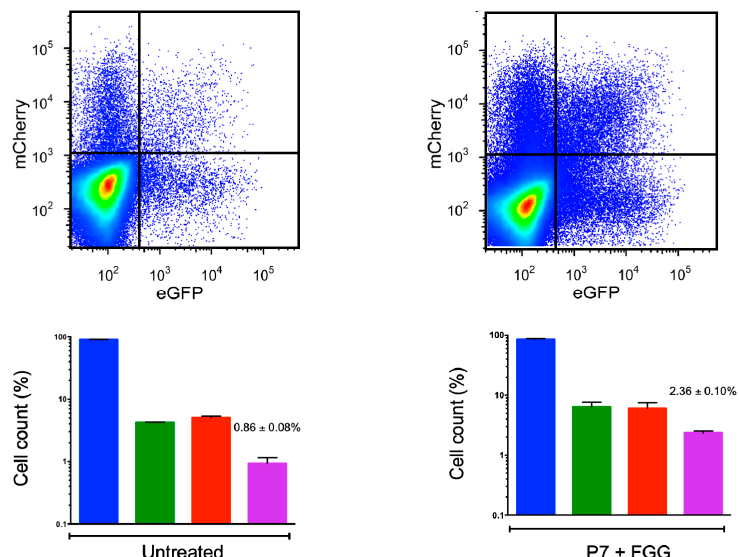
Figure 3. Fibrinogen gamma-chain (FGG) effect on vesicular stomatitis virus (VSV) aggregation assayed by flow cytometry . Top: Scatter plots (>100,000 events) showing non-infected (blue), mCherry-positive (red), eGFP-positive (green), and doubly fluorescent (purple) cells at 6 hpi in cultures inoculated with a 1:1 mix VSV-mCherry VSV-eGFP (0.1 PFU/cell). Prior to inoculation, the mix was either incubated (1 h, 37 °C) in saliva from donor P7 or in P7 saliva supplemented with recombinant FGG (125 ng/mL). Scatter plot data show one out of the three technical replicates conducted. Bottom: histograms showing the mean percentage of foci positive for eGFP only (green), mCherry only (red), and doubly fluorescent foci (purple) from three technical replicates (error bars: SEM).